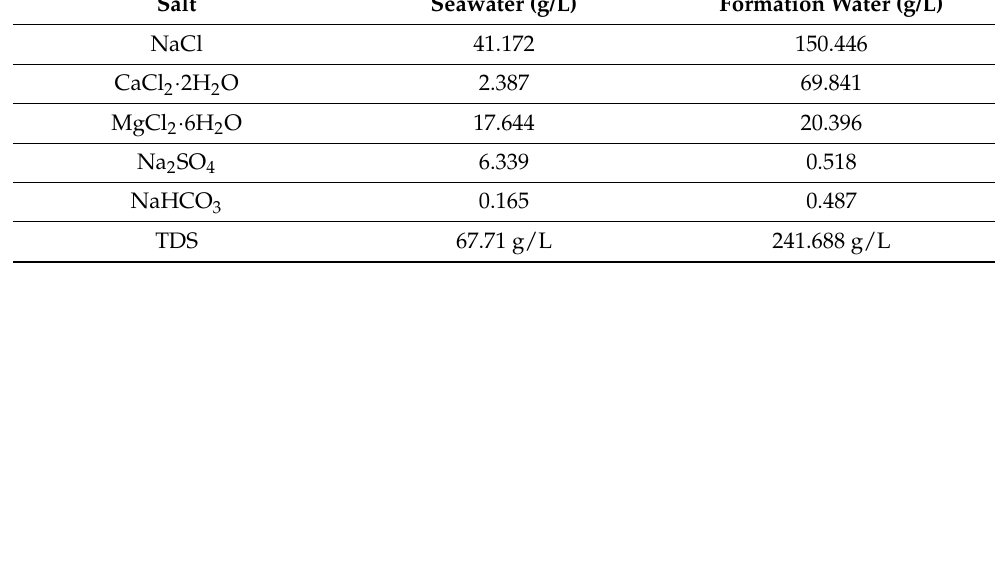
Table 1. Composition of seawater and formation water.